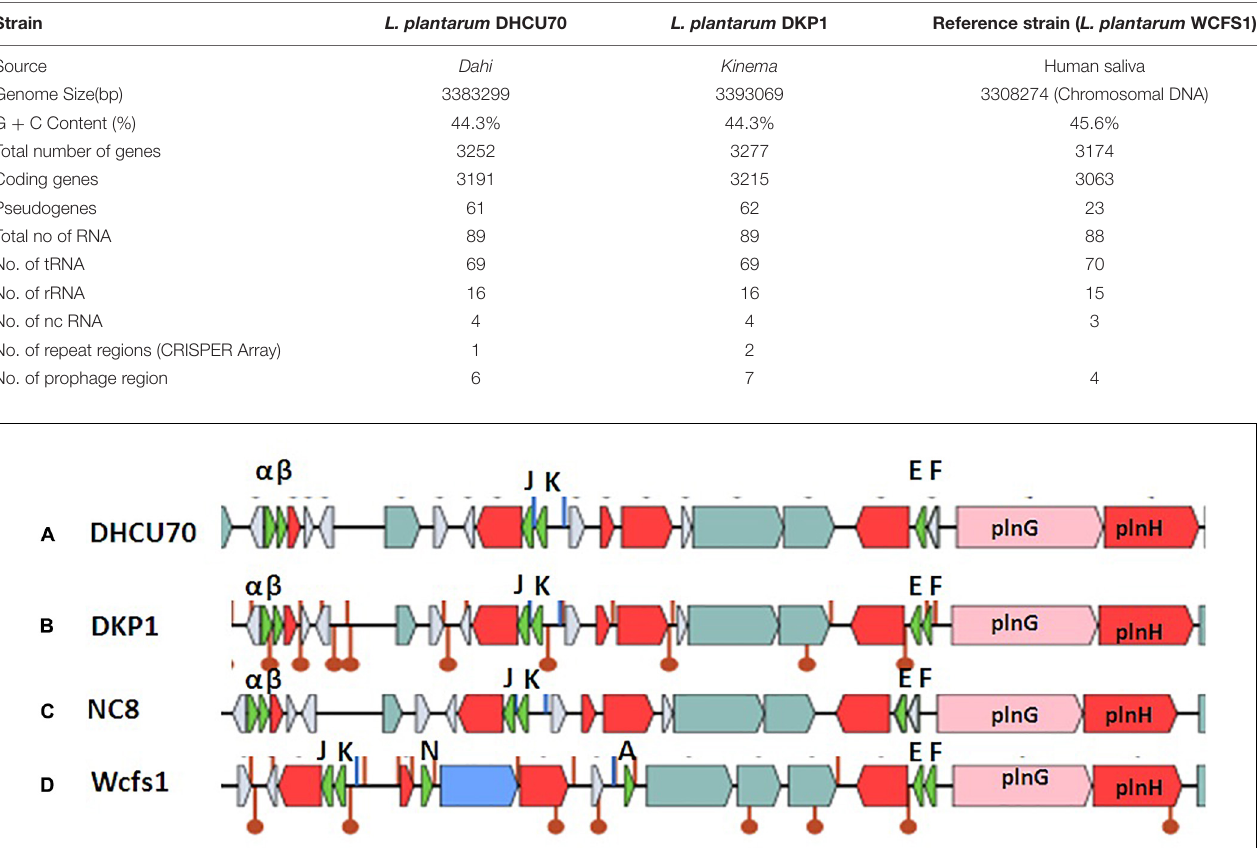
peptide encoding genes pln c8IF and histidine protein